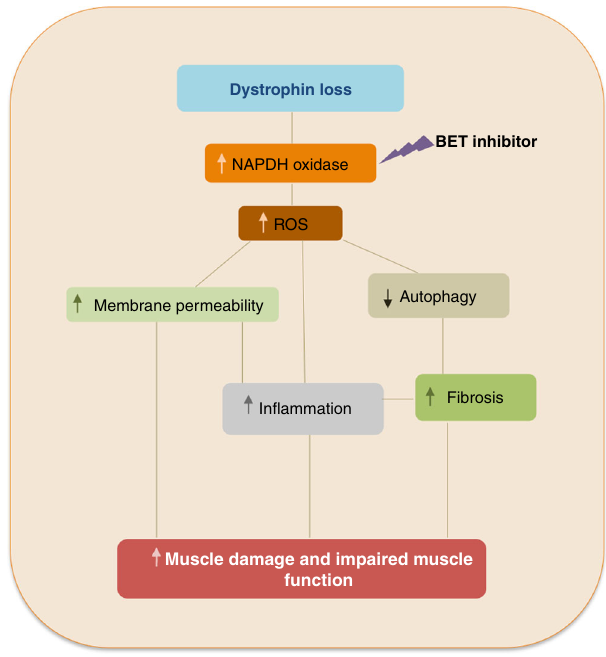
Fig. 8 BET treatment and DMD physiopathology. Working model for BET inhibitors effects on functional impairment in dystrophic